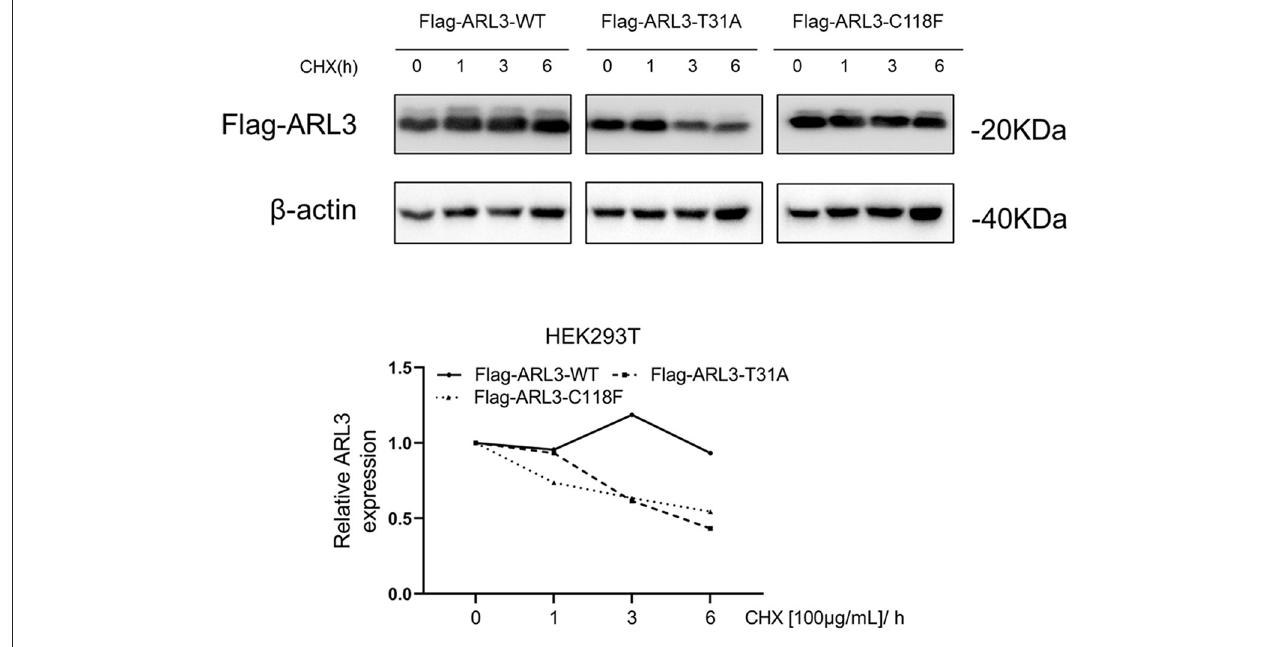
FIGURE 5 | The ARL3 variants T31A and C118F impaired the stabilities of the encoded proteins in HEK293T cells. HEK293T cells were transfected with empty vector, wild-type, ARL3 T31A and C118F vectors for 24h and then treated with 100 µ g/ml cycloheximide (CHX) for 1, 3, and 6h, respectively. ARL3 protein levels were detected using the flag antibody. The protein levels of β -actin were used as endogenous control ( n =